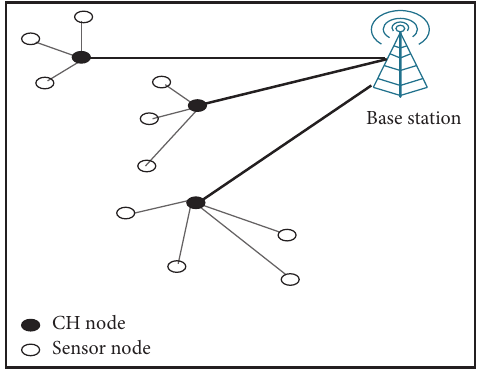
Figure 2: Structure of the steady-state